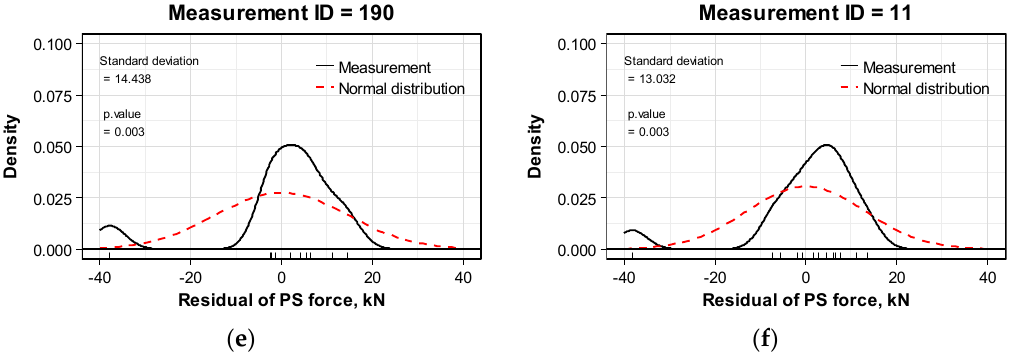
Figure 9. Comparison of the distribution of prestress force per anchor head and the normal distribution: ( a , b ) Examples of good agreement with the normal distribution; ( c , d ) Examples of medium agreement with the normal distribution; ( e , f ) Examples of disagreement with the normal distribution.